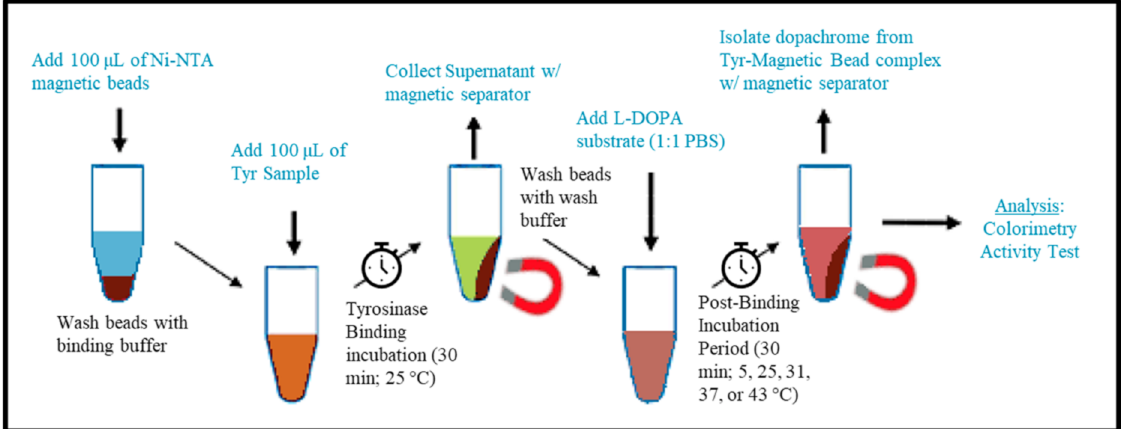
Figure 6. Dopachrome isolation flowchart. Dopachrome isolation begins with washing the MB with binding buffer, adding Tyr (1:1 ratio) and performing the Tyr binding incubation (TBI) for 30 min at 25 ◦ C. The supernatant is then removed after the incubation and the beads were washed with washing buffer. Afterwards, L-DOPA is added with 1 × PBS (1:1 ratio) into the tube containing MB and the final post-binding incubation (PBI) for 30 min at any temperature desired is performed. Using a magnetic separator, the dopachrome product can then be isolated for the colorimetry activity